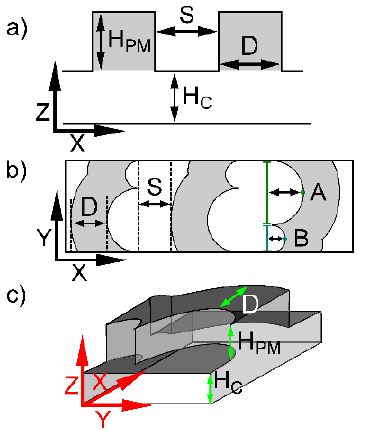
Figure 1. Schematic illustration of microfluidic channel designs showing relevant parameters. The overall transverse widths of each channel were 100 µm. ( a ) Side view of a channel design with passive mixing structures in the ceiling where the design parameters are as follows: H c depicts the channel height; H PM is the passive mixer height. ( b ) Top view depicting the passive mixer depth, D, and passive mixer spacing, S, for DCMS, where the short arm to perpendicular intersection is 30 µm (teal line) and long arm is 70 µm (green line). A = 35 µm and B = 15 µm. ( c ) 3D view of DCMS also depicting the location of H c , H PM and D.